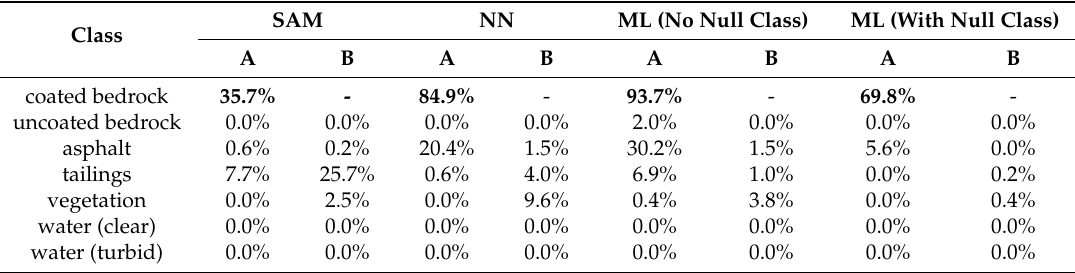
Figure 10. Maps of black coatings and other classes of interest for areas near the Copper Cliff ( a , b ) and Coniston ( c ) smelters, based on neural network classification of the nine-channel multispectral databases generated from Hyperion images. Areas affected by cloud cover in the Coniston study area are masked by black rectangles. Image footprints and smelter stack locations are given in Figure 1. Selected lakes and other landmarks are labeled in Figures 6 and 7. Table 1. Spectral angle mapper (SAM), neural network (NN), and maximum likelihood (ML) results for the Copper Cliff study area (Figures 9–12). A: proportion of test pixels correctly classified (bold) or misclassified as coated bedrock (errors of commission). B: proportion of coated bedrock test pixels misclassified as uncoated classes (errors of omission).